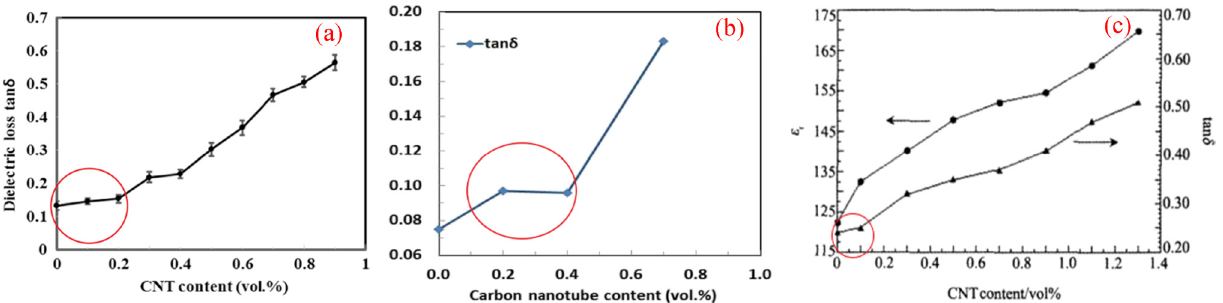
Figure 8: The dielectric loss of CNT/PCM: ( a ) ref. [ 86 ] , ( b ) ref. [ 87 ] , and ( c ) ref. [ 94 ]